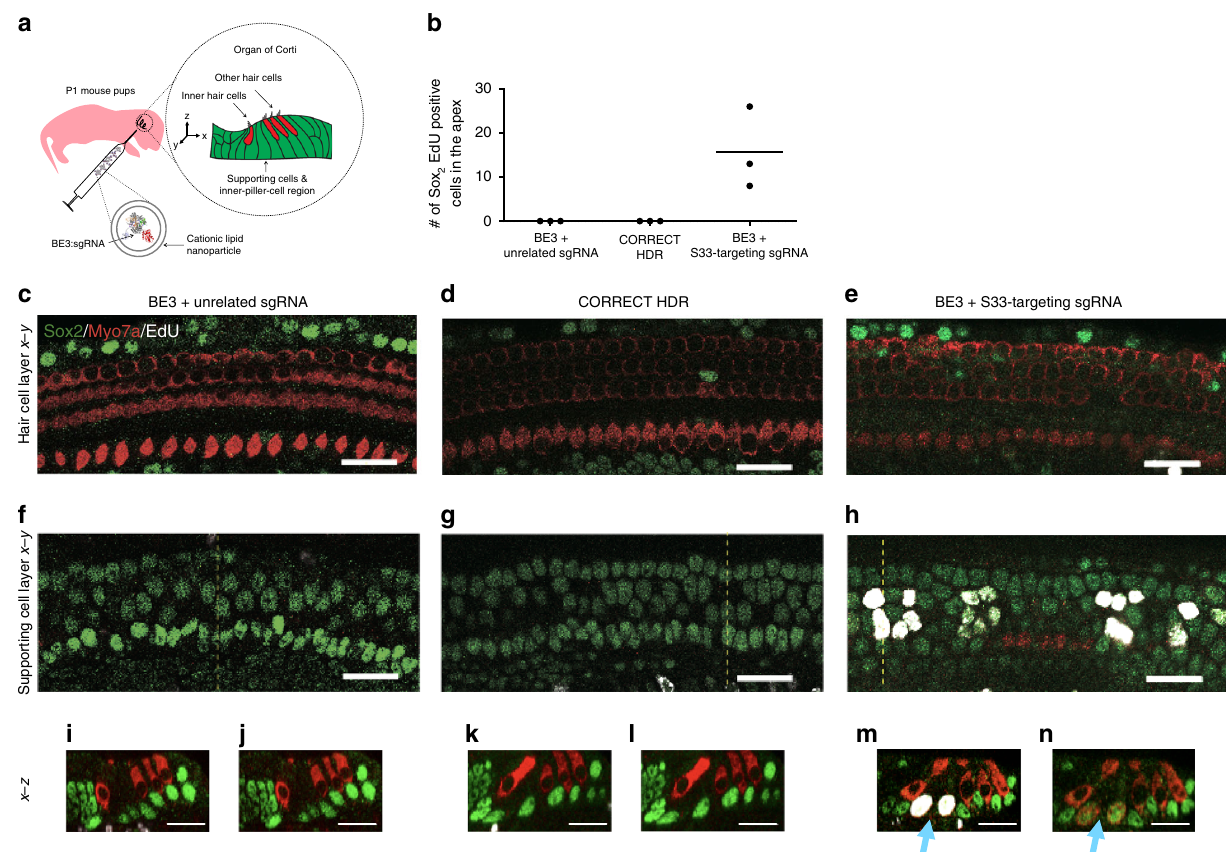
Fig. 4 Outcomes associated with in vivo RNP-mediated base editing in post-mitotic cochlea. a The cochlea of a postnatal day 1 (P1) mouse was injected with lipid nanoparticles encapsulating BE3 + sgRNA, CORRECT HDR agents, or controls. The next day, mice received 5-ethynyl-2-deoxyuridine (EdU) by subcutaneous injection once per day for 5 days. At postnatal day 7 (P7), one day after the fi fth EdU injection, the cochlea was dissected and organ of Corti was visualized by chemical staining (to visualize EdU) and immuno fl uorescence (Myo7a and Sox2). In the cochlea, Myo7a (red) is expressed in hair cells and Sox2 (green) is expressed in supporting cells. EdU (white) marks newly divided cells. b Quanti fi cation of Sox2 and EdU double-positive cells at the apical region of the organ of Corti from mice treated with BE3 + S33-targeting sgRNA ( n = 3), CORRECT HDR agents ( n = 3), or BE3 + unrelated sgRNA ( n = 3). Values and error bars re fl ect mean and S.E.M. c – n Images from the organ of Corti tissue of mice treated with BE3 + unrelated sgRNA ( c , f , i , j ); CORRECT HDR agents ( d , g , k , l ); or BE3 + S33-targeting sgRNA ( e , h , m , n ). The blue arrows point to triple-positive cells that had undergone proliferation and reprogramming to cells expressing Myo7a. c – e x – y plane of hair cell layers. f – h x – y plane of supporting cell layers. ( i , k , m ) x – z plane of samples in f , g , h at the dotted yellow lines. j , k , m x – z plane of samples in f , g , h at the dotted yellow lines, but with the Myo7a and Sox2 channels shown. Scale